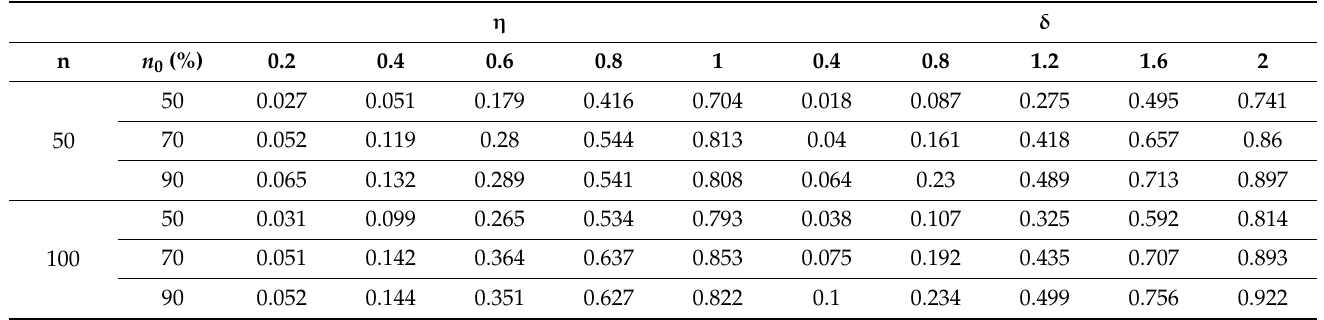
Table 4. Results of power estimates (1-Type II error) for variation in shape ( η ) and magnitude ( δ ) for